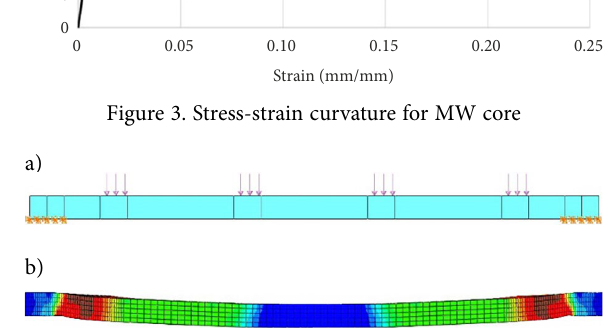
Figure 4. Finite element models of the sandwich panel: